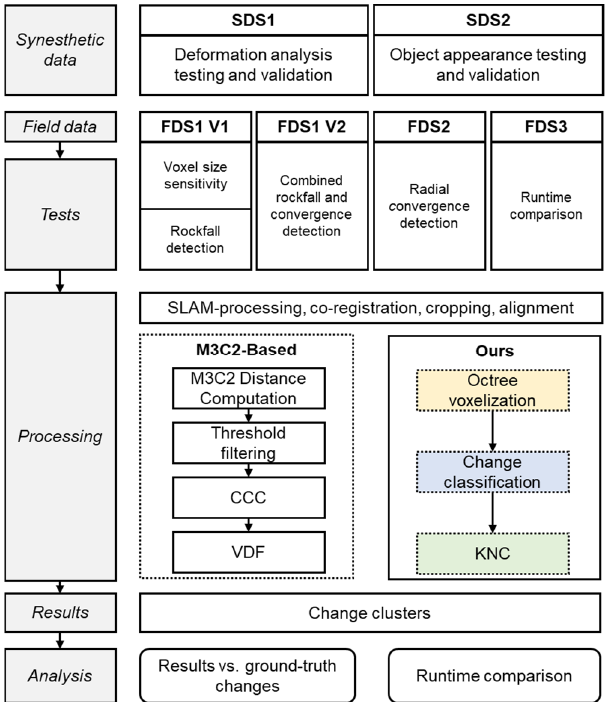
Figure 6. Flowchart of our study methodology for SDS1-2 and